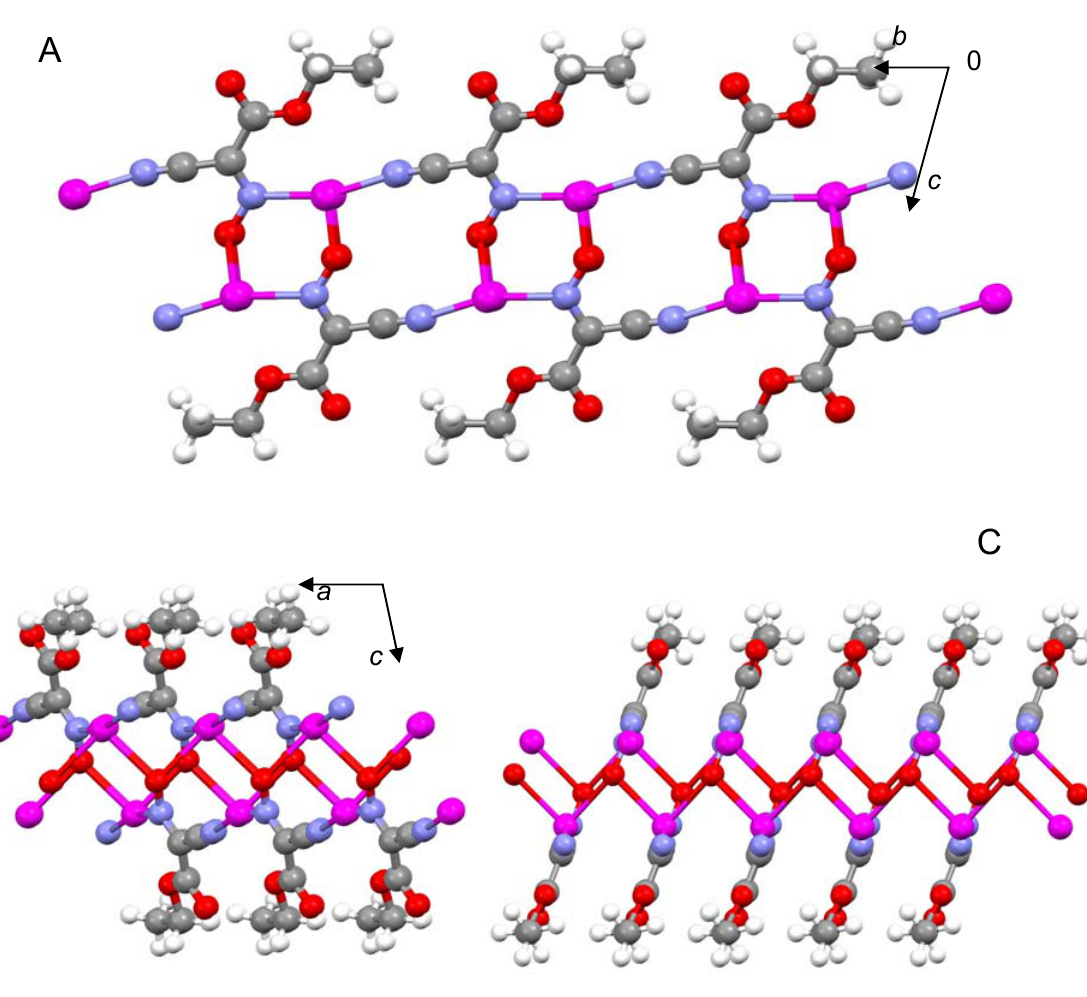
Figure 17. Organization of layered 2D structure of Ag(ECO): view of two unit cells along a showing polymeric motif ( A ), and two views along b ( B ), and ab -diagonal of the unit cell ( C